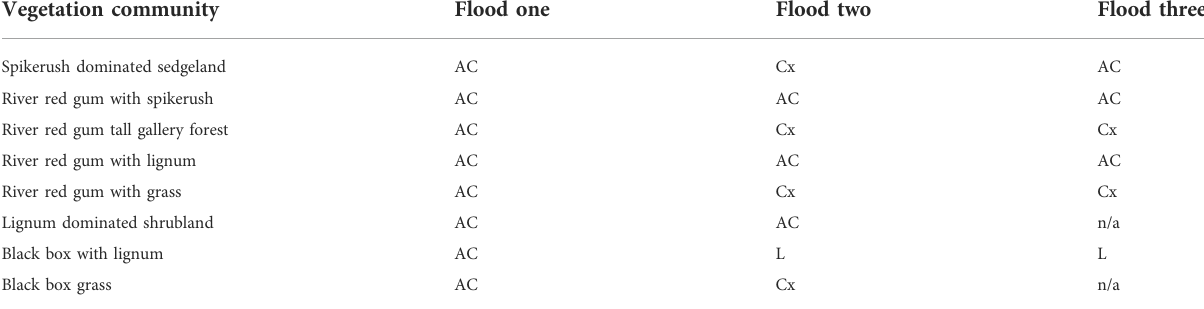
TABLE 2 Inundation patterns observed within vegetation community landscapes. Vegetation